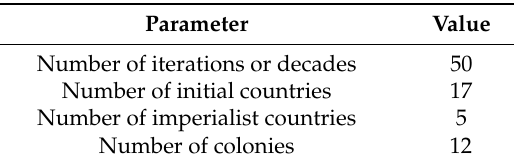
Table 6. ICA parameters.